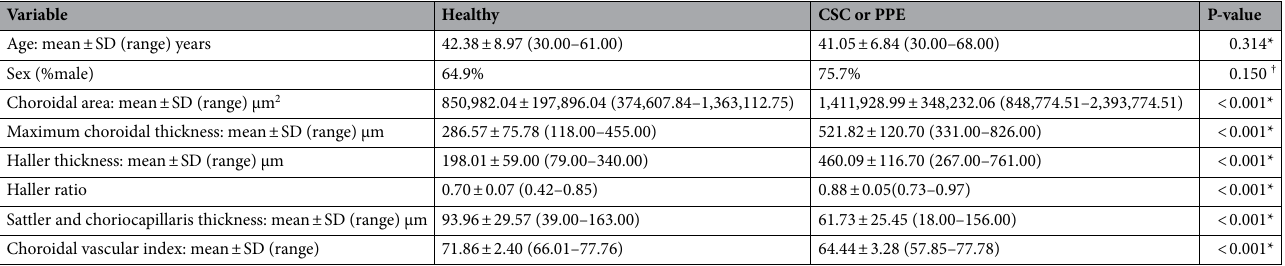
Table 1. Demographics and choroidal metrics of patients with central serous chorioretinopathy or pachychoroid pigment epitheliopathy and healthy subjects in the training dataset. CSC central serous chorioretinopathy, PPE pachychoroid pigment epitheliopathy, SD standard deviation. *Student t test. † Chi- square test.